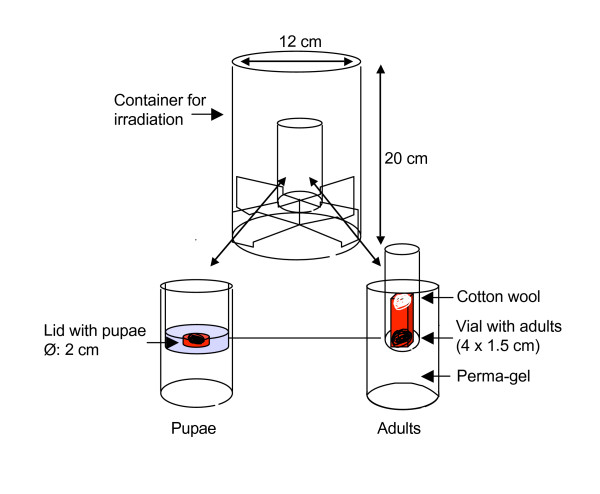
Insects were irradiated in a confined space in the centre of the irradiation chamber to minimize maximise dose uniformity within the batch. Devices used for the irradiation of pupae and adults are shown.